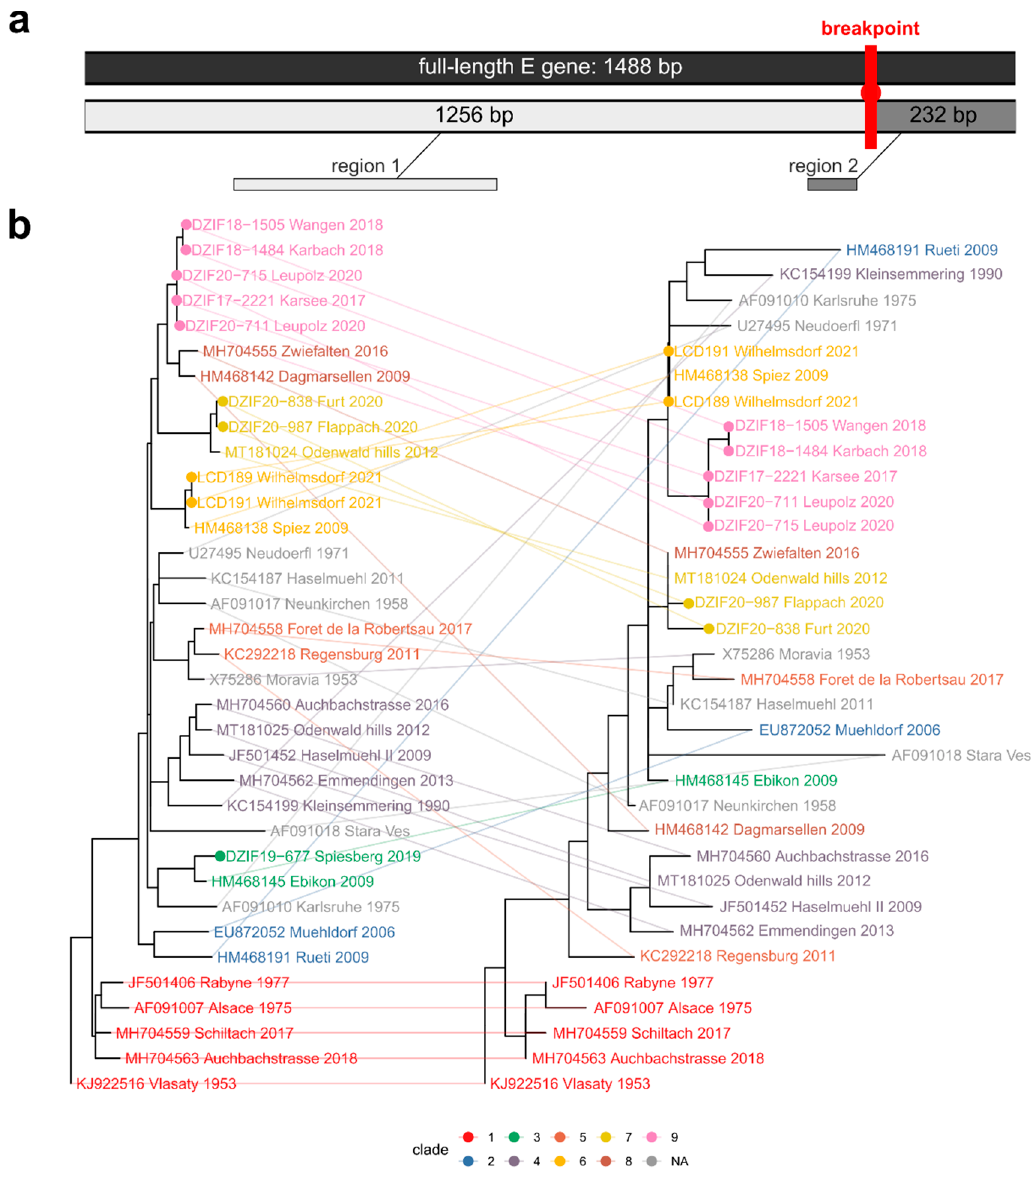
Figure 4. Phylogenetic inference of virus strains from the nine natural TBEV foci in the Ravensburg district in the context of representative clades from the published European TBEV E gene diversity. ( a ) Schematic depiction of the full E gene (upper gray bar) and two inferred putative recombination tracts (regions 1 and 2; lower gray bars). A red vertical line indicates the position of the predicted recombination breakpoint (at amino acid residue 699 of the TBEV polyprotein). ( b ) Co-phylogram plot of the maximum likelihood tree topologies inferred using the respective optimal model for the alignments of the two putative recombination tracts in the E gene as depicted in panel ( a ). Corre- sponding tips in the three tree topologies are displayed as clade-color-coded inter-tree edges. The ten sequenced TBEV isolates are highlighted by colored dots. Significantly supported phylogenetic clades (bootstrap support > 70%) in the phylogenetic analysis of sequence region 1 are indicated via coloring of tip labels and inter-tree connections as depicted in the bottom legend. Gray coloring (NA) indicates singleton taxa, which did not cluster in such a significant clade. The topology of the tree inferred from the full-length alignment (not shown) is almost identical to that of region 1. To account for possible impact on the phylogenetic signal in those regions, we con- ducted the subsequent phylogenetic analyses on the individual MSAs of the full-length E gene sequence as well as the sequence regions of the two putative recombination tracts sep-